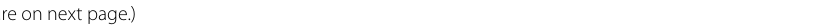
figure on next Fig. 1 LncRNA MAPKAPK5-AS1 is upregulated, while miR-124-3p is down-regulated in myocardial injury induced by LPS. A TUNEL staining for cell apoptosis (gray) in the groups of Vehicle, LPS (5 mg/mg), and LPS (10 mg/kg), scale bar: 50 μm. B IHC for TNF-α positive cells (gray) per 200 field in × groups of vehicle, LPS (5 mg/mg), and LPS (10 mg/kg), scale bar: 50 μm. C IHC for CD68 positive cells (gray) per 200 field in the groups of Vehicle, × LPS (5 mg/mg), and LPS (10 mg/kg). D and E LPS treatment reduced the cardiac function in a dose-dependent manner. F Relative MAPKAPK5-AS1 expression in heart tissue in the groups of Vehicle, LPS (5 mg/mg), and LPS (10 mg/kg). G MiR-124-3p expression in heart tissue in the groups of Vehicle, LPS (5 mg/mg), and LPS (10 mg/kg). Each column represents the mean SEM. Statistical differences were evaluated with One-way ANOVA ± followed by Tukey’s post-hoc test. *P < 0.05, **P < 0.01, ***P < 0.001, n =